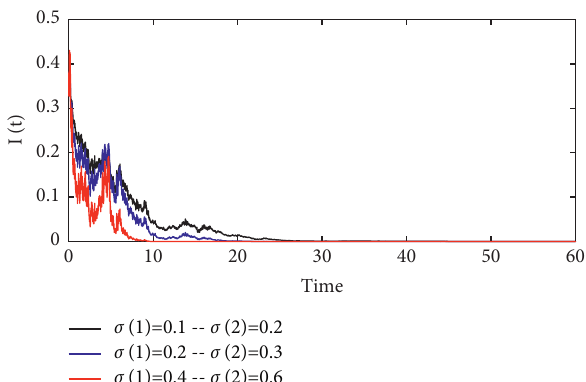
Figure 3: The stochastic trajectory of I ( t ) with different noise values.